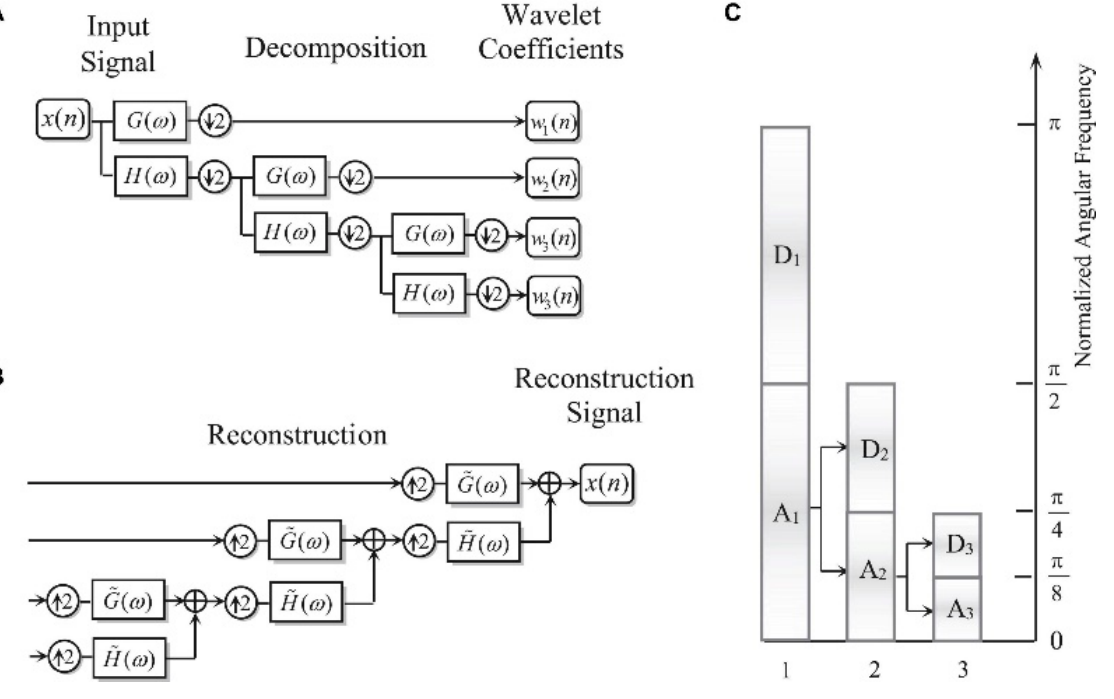
Figure 4. ( A ) The decomposition process of wavelet transform; ( B ) the reconstruction process of wavelet transform; and ( C ) the theoretical spectral passing band of wavelet transform.